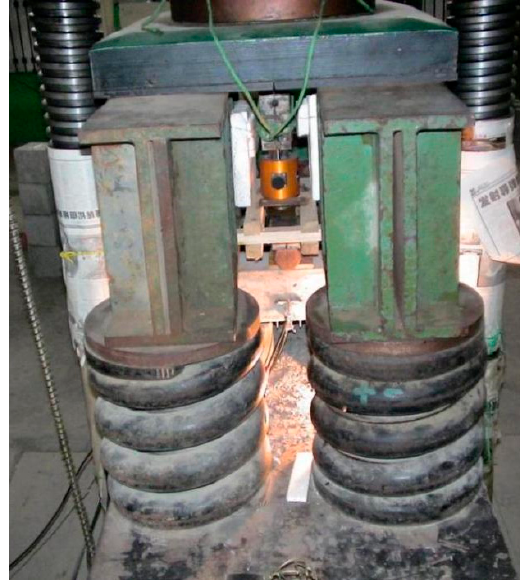
Figure 4. The photo of three-point bending test machine.